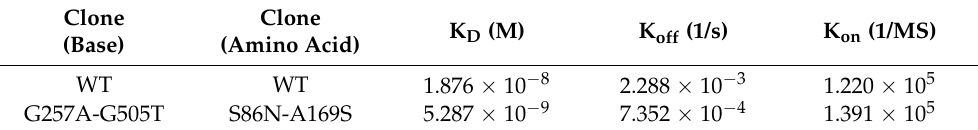
Table 4. Affinities of different mutations of human kappa CL